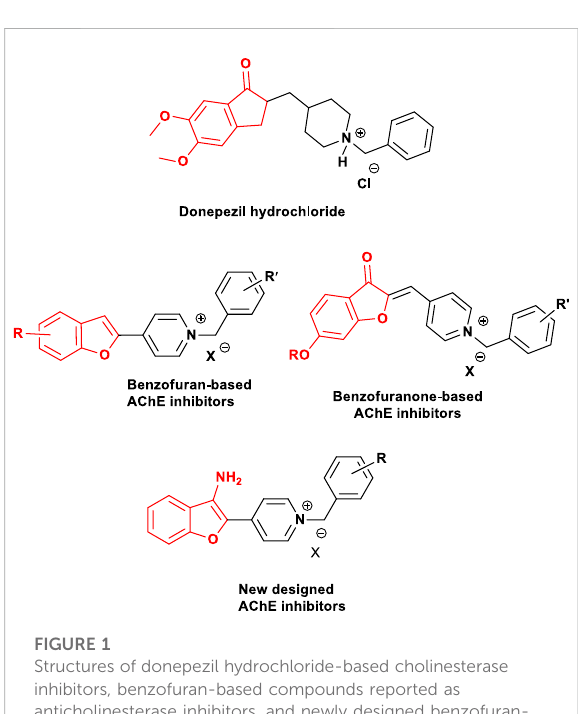
FIGURE 1 Structures of donepezil hydrochloride-based cholinesterase inhibitors, benzofuran-based compounds reported as anticholinesterase inhibitors, and newly designed benzofuran- based derivatives (Baharloo et al.,